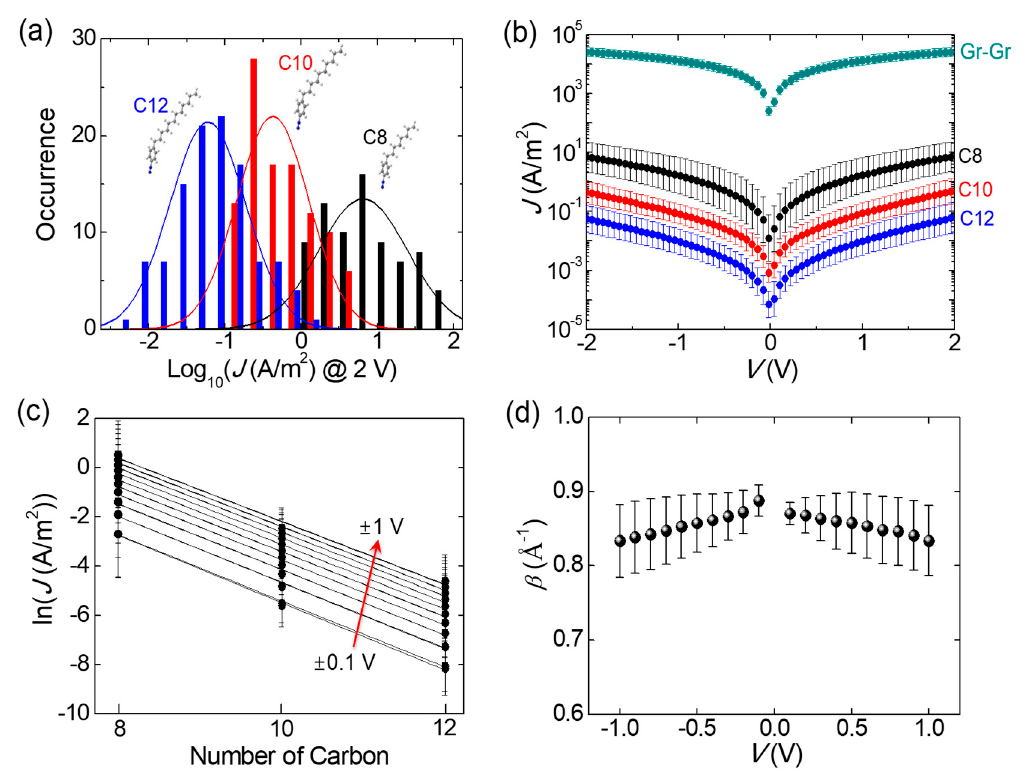
Figure 3. ( a ) Statistical histograms of the current density at 2 V for C8, C10 and C12 junctions. The peak position of Gaussian distribution indicates the most probable value for each junction. ( b ) Statistical representative J − V curves on a log scale, obtained from the devices within 3 σ regimes of Gaussian distribution. The error bars denote the standard deviation for averaging. ( c ) Plots of ln(J) versus the number of carbons at different voltages. β is determined by the slopes of the linear fits. ( d ) Plots of the β values from − 1 V to 1 V. Error bars denote the uncertainty about the linear fits.